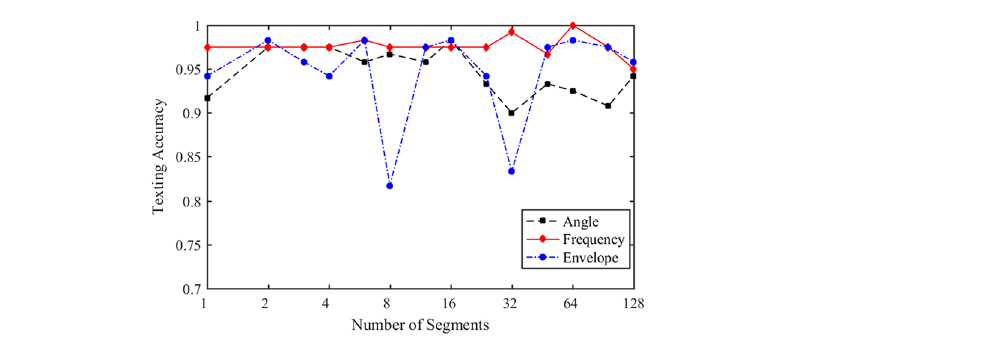
Figure 16. Effect of segment number on network